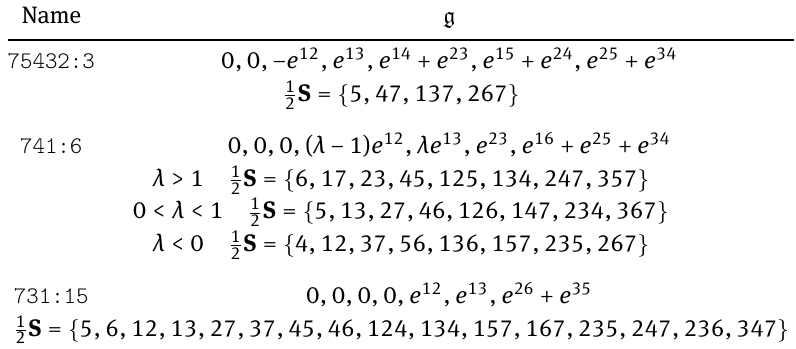
Table 2: 7-dimensional nice nilpotent Lie algebras that satisfy ( K ), ( H ), ( L ) and ( P ) for k = 0